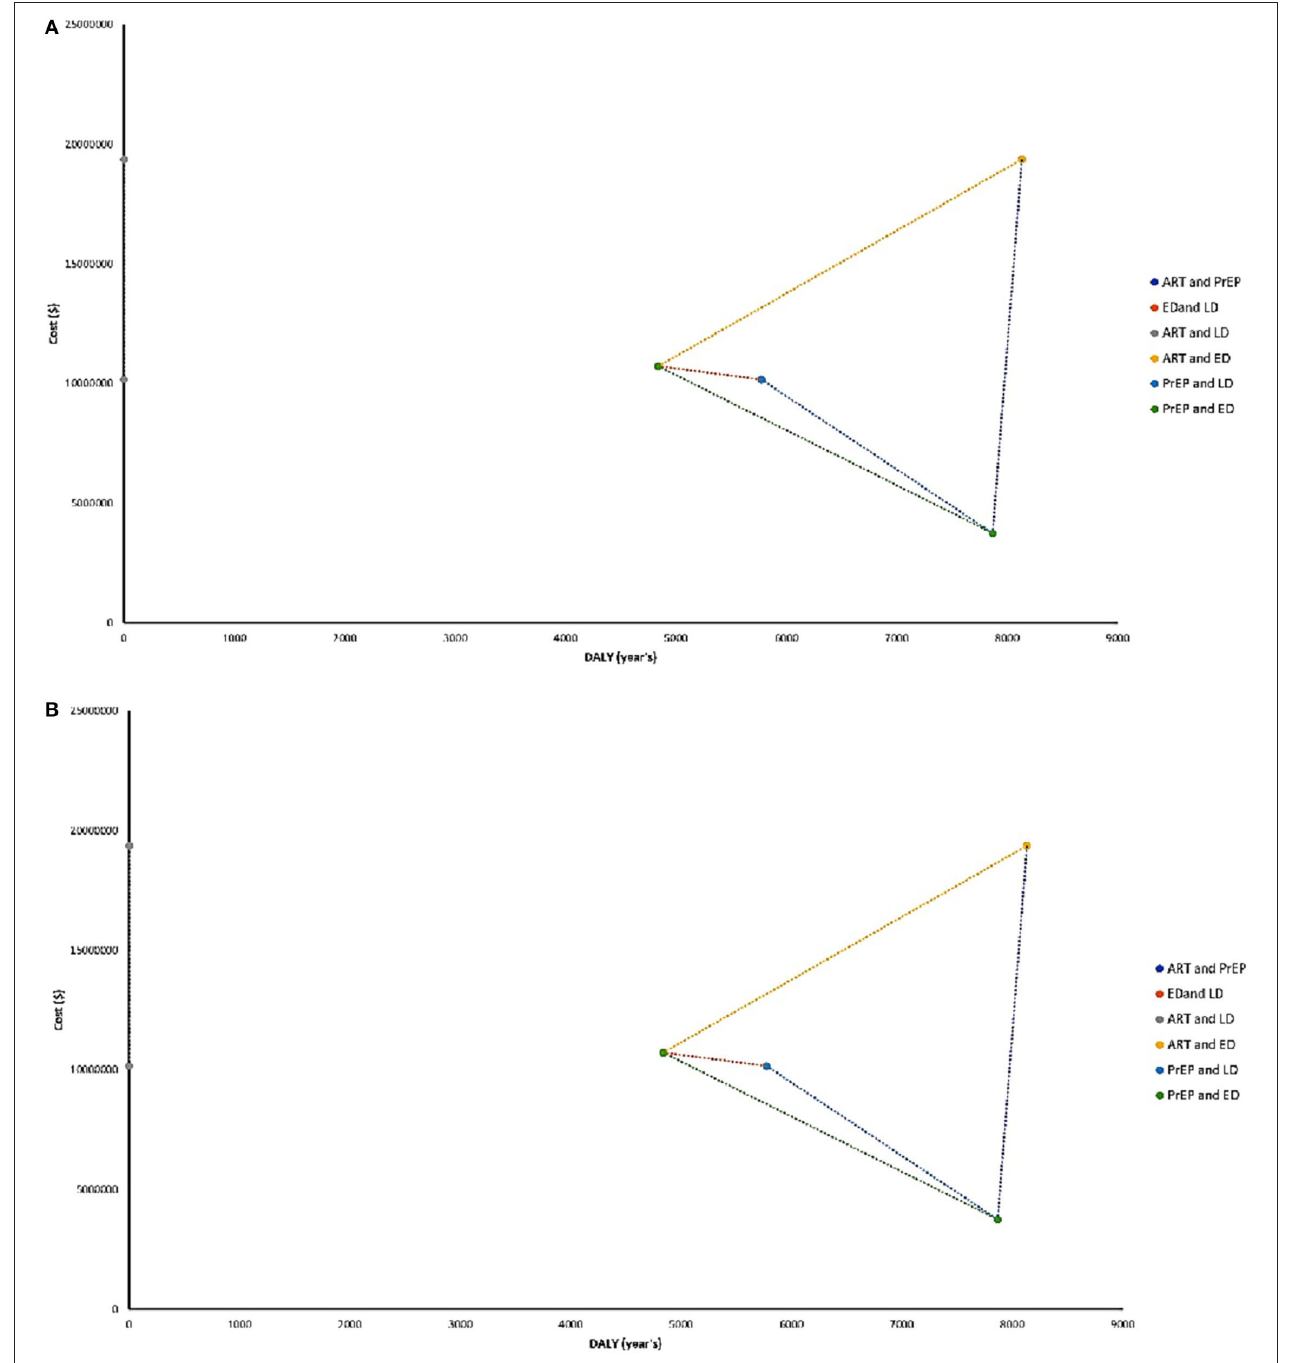
FIGURE 4 | (A) ICERs with both analyses using a deterministic data distribution. (B) ICERs with both analyses using stochastic data distribution. ART, antiretroviral therapy; PrEP, prophylactic treatment; ED, early diagnosis; LD, late diagnosis.